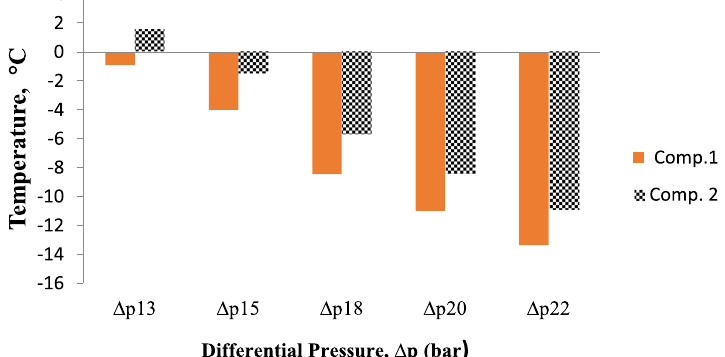
of natural gas, C1 and